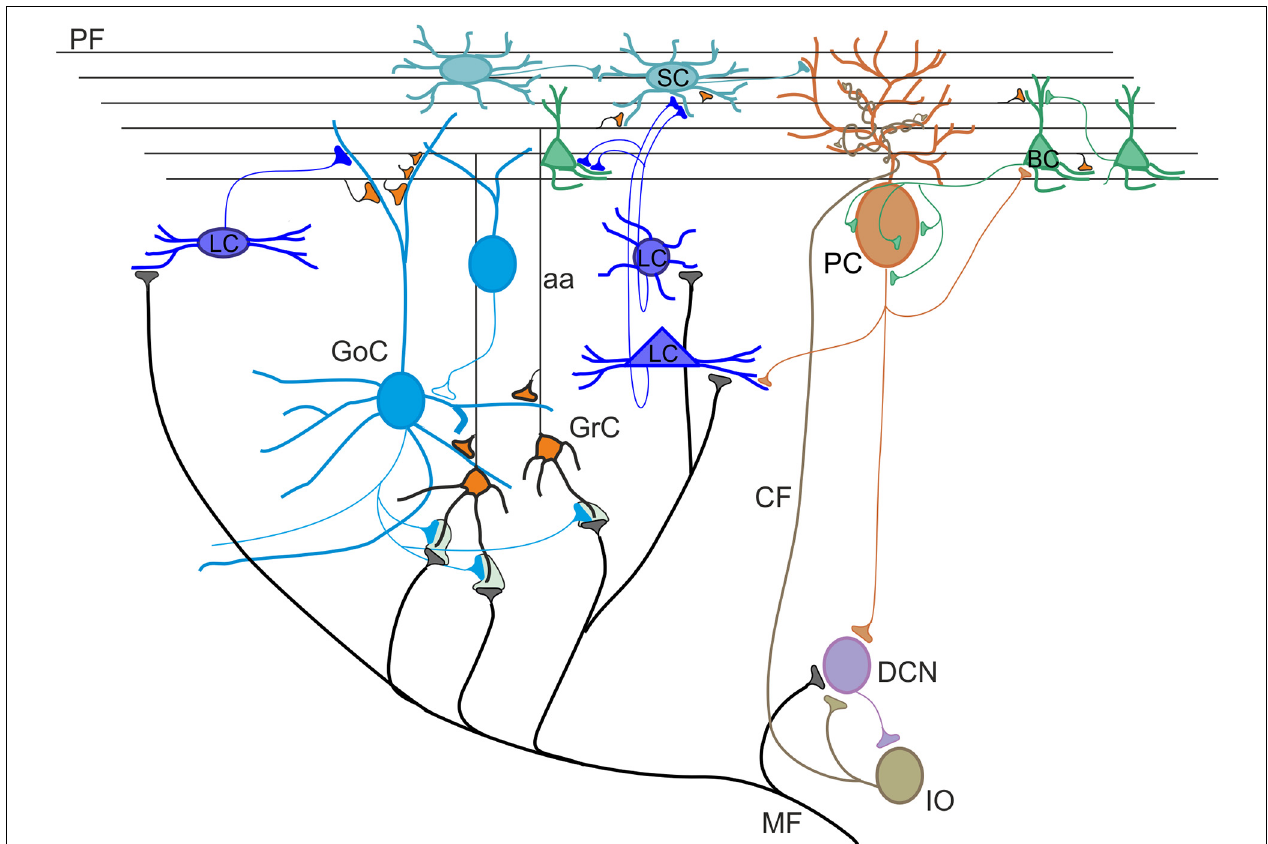
FIGURE 1 | Schematic view of the cerebellar circuit. All cells in the cerebellar cortex are inhibitory except granule cells and unipolar brush cells (not shown). The cerebellar cortex receives two excitatory inputs from mossy fibers (MF) originating in various brain stem and spinal cord nuclei and from climbing fibers (CF) originating from the inferior olive (IO). Mossy fibers contact the granular layer [GL; containing granule cells (GrC), Golgi cells (GoC) and Lugaro cells (LC)] and the deep cerebellar nuclei (DCN). Climbing fibers contact Purkinje cells (PC) and DCN. The ascending axon (aa) of the GrC bifurcates in the molecular layer (ML) forming the parallel fibers (PF), which synapse onto PCs and ML interneurons [stellate cells (SCs) and BCs]. The only output of the cortex is provided by PCs, which project to the DCN. The activity of PCs is under inhibitory control by SC and BC. SC and BC mutually inhibit each other and are coupled through gap junctions. Modified from D’Angelo et al.